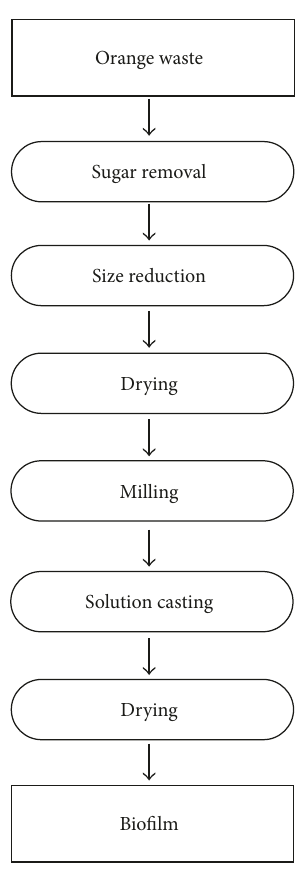
Figure 1: Flow chart of the developed method for production of orange waste